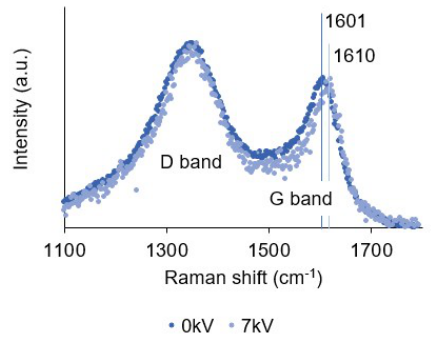
Figure 10. Raman spectra of the ACC samples, with and without the applied electric field.